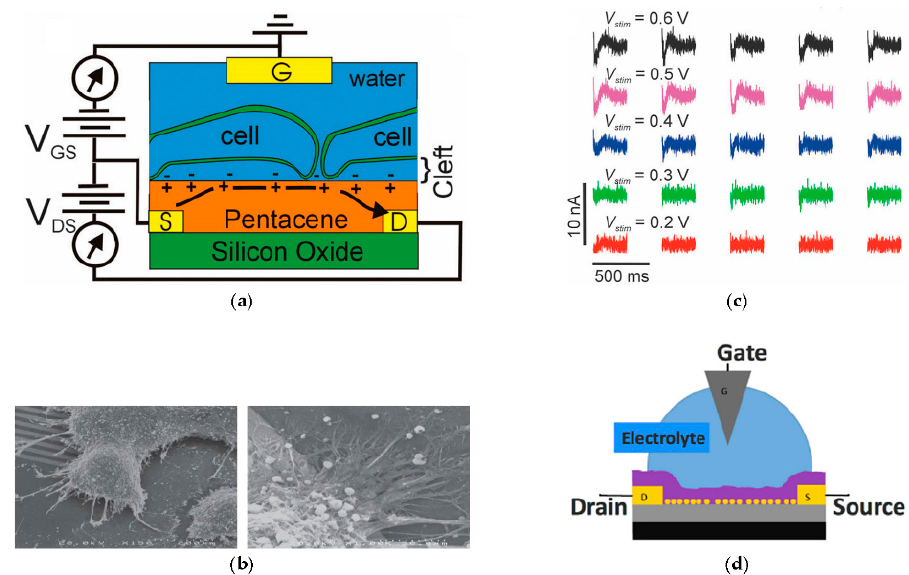
Figure 12. ( a ) Schematic of the pentacene-based EGOFET interfaced with neurons; ( b ) SEM micrographs: details of neurons on active devices at day 9 after performing the electrical analysis; ( c ) Current traces measured after stimulations of varying intensity; ( d ) Schematic representation of the EGOFET with gold nanoparticles incorporated in the semiconductor. ( a – c ) Reproduced from [138] with permission of the PCCP Owner Societies. Copyright 2013. https://doi.org/10.1039/C3CP44251A; ( d ) Reprinted from [139]. Copyright 2016, with permission from Elsevier.